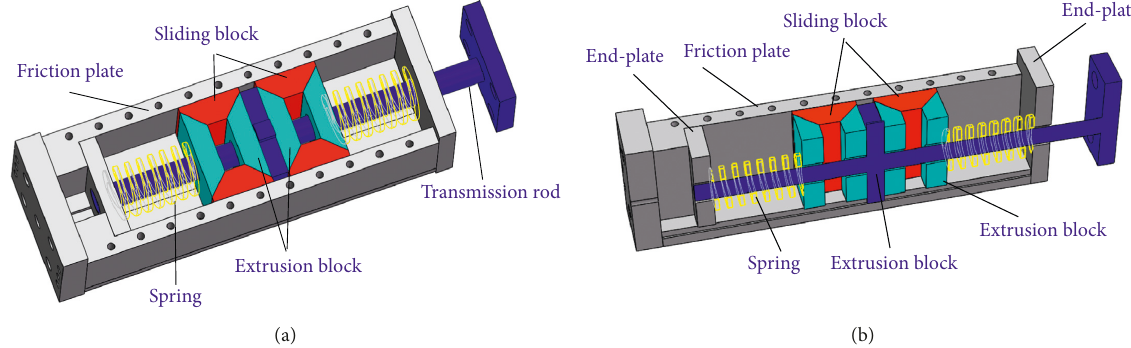
Figure 5: Detailed construction of the Reid variable friction damper: (a) three-dimensional model of the damper; (b) profile of the damper.